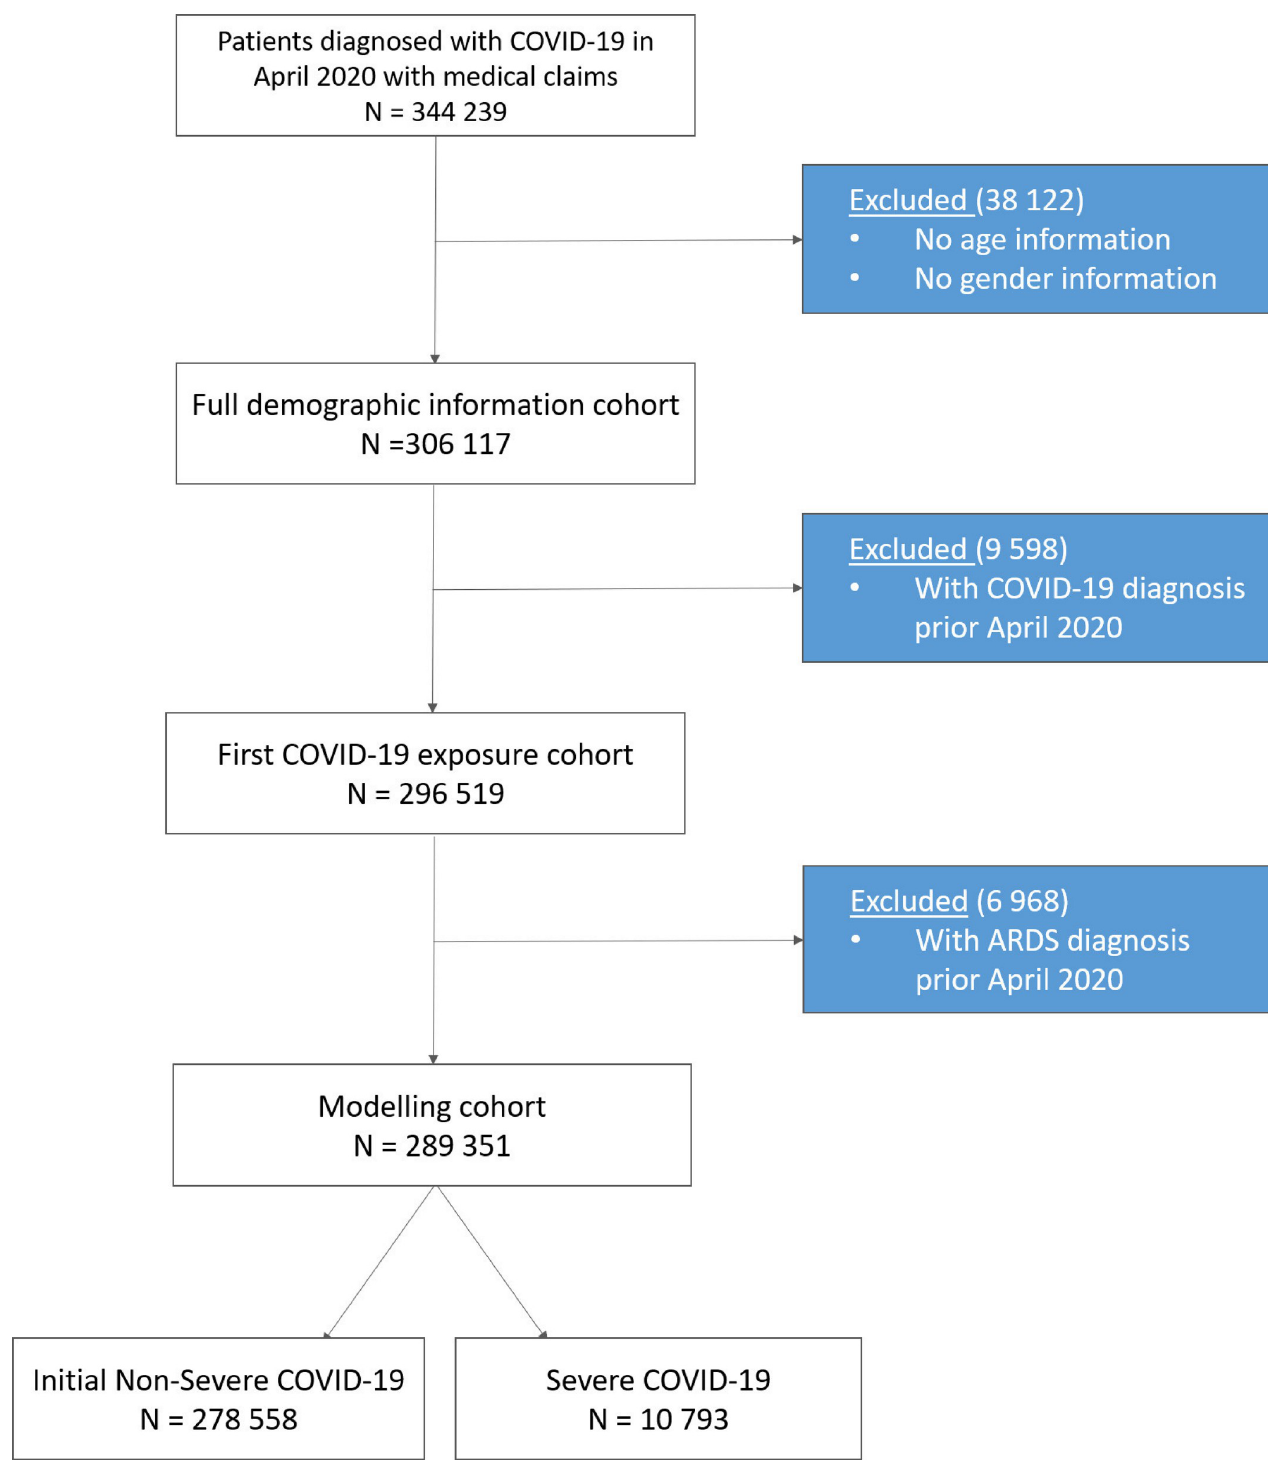
Fig 1. Consort diagram for the study. Consort flow diagram illustrating the rules implemented for selecting patients for modelling cohort.